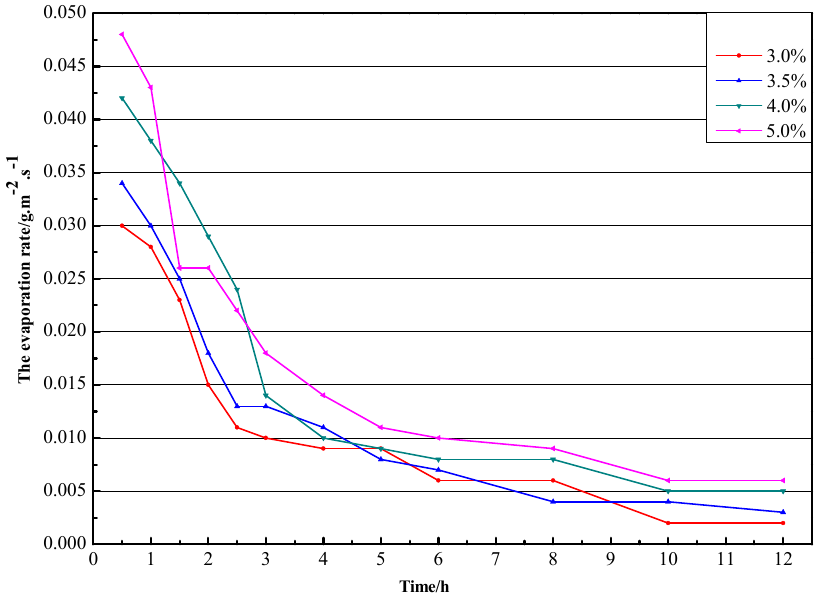
Figure 2. Trend chart of sample evaporation rate with time (concentration 0%, 1%, 1.5%, 2%, 2.5%).